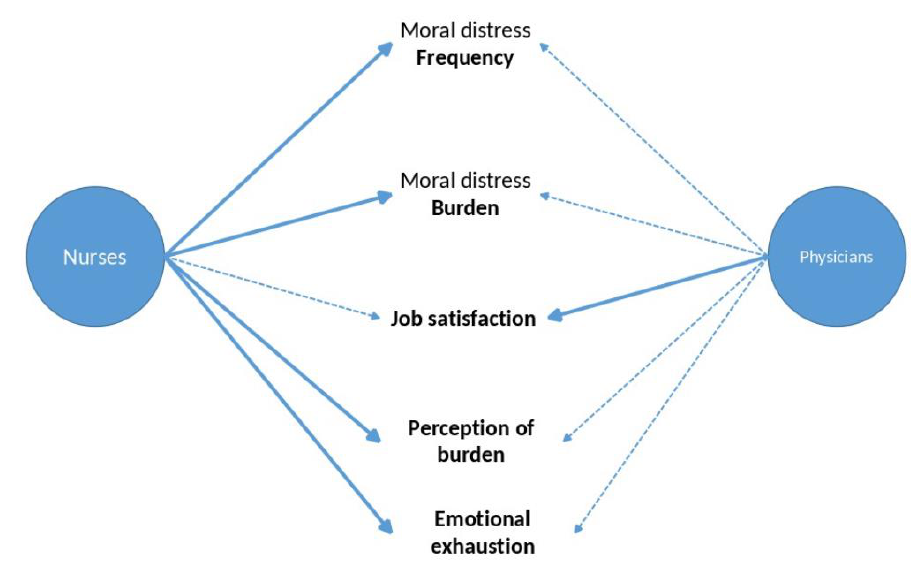
Figure 1. Physicians and nurses: main influences.